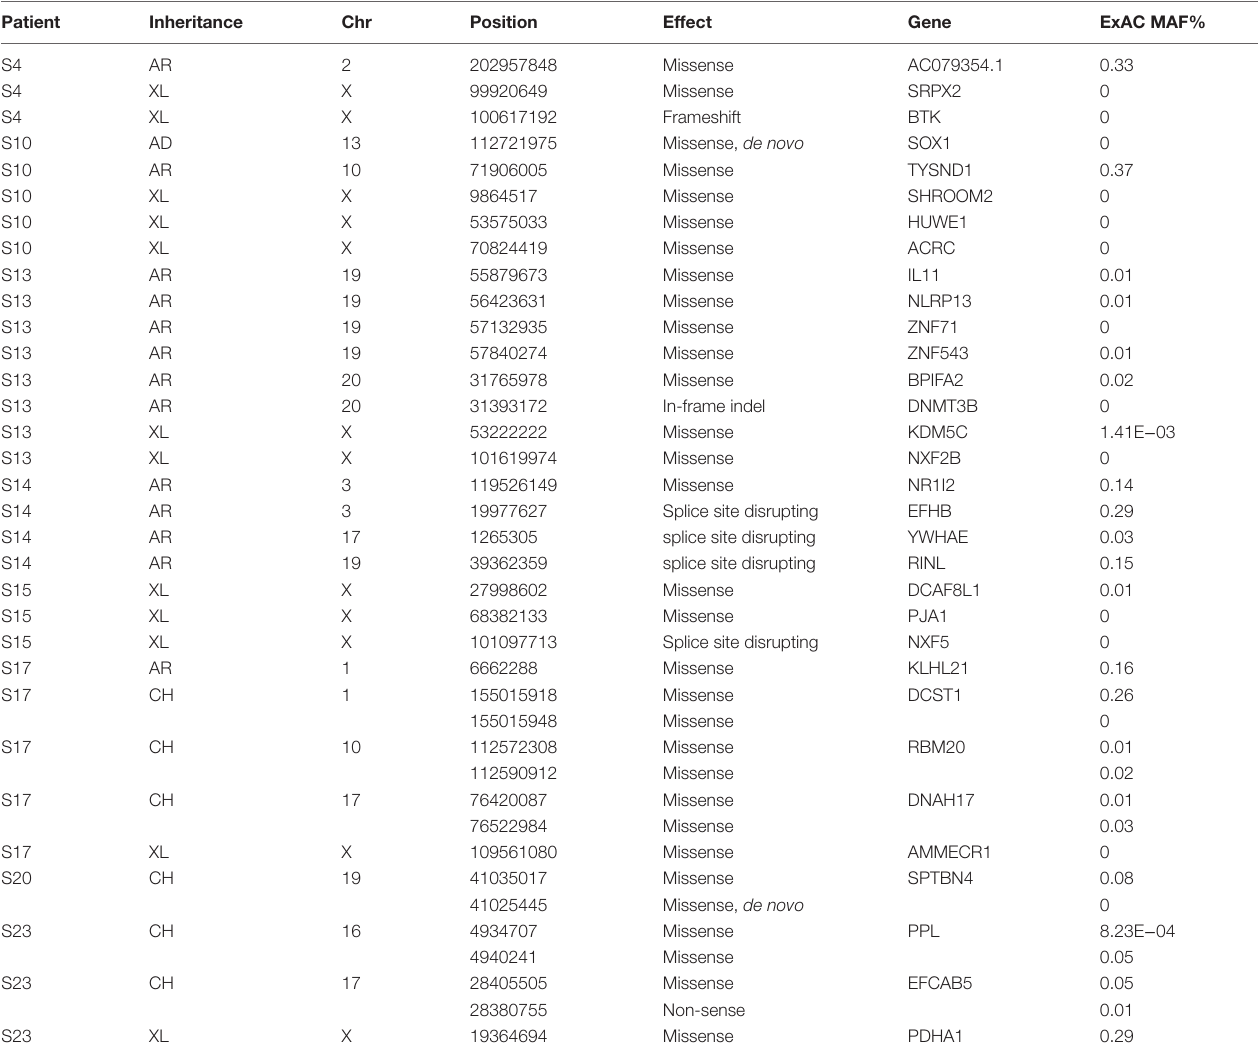
TaBle 3 | 38 rare (MaF < 1% in esP, 1KP, UK10K, exac, and in-house controls) non-synonymous and putative loF variants found in our 11 patients using different inheritance models (see Materials and Methods for details).